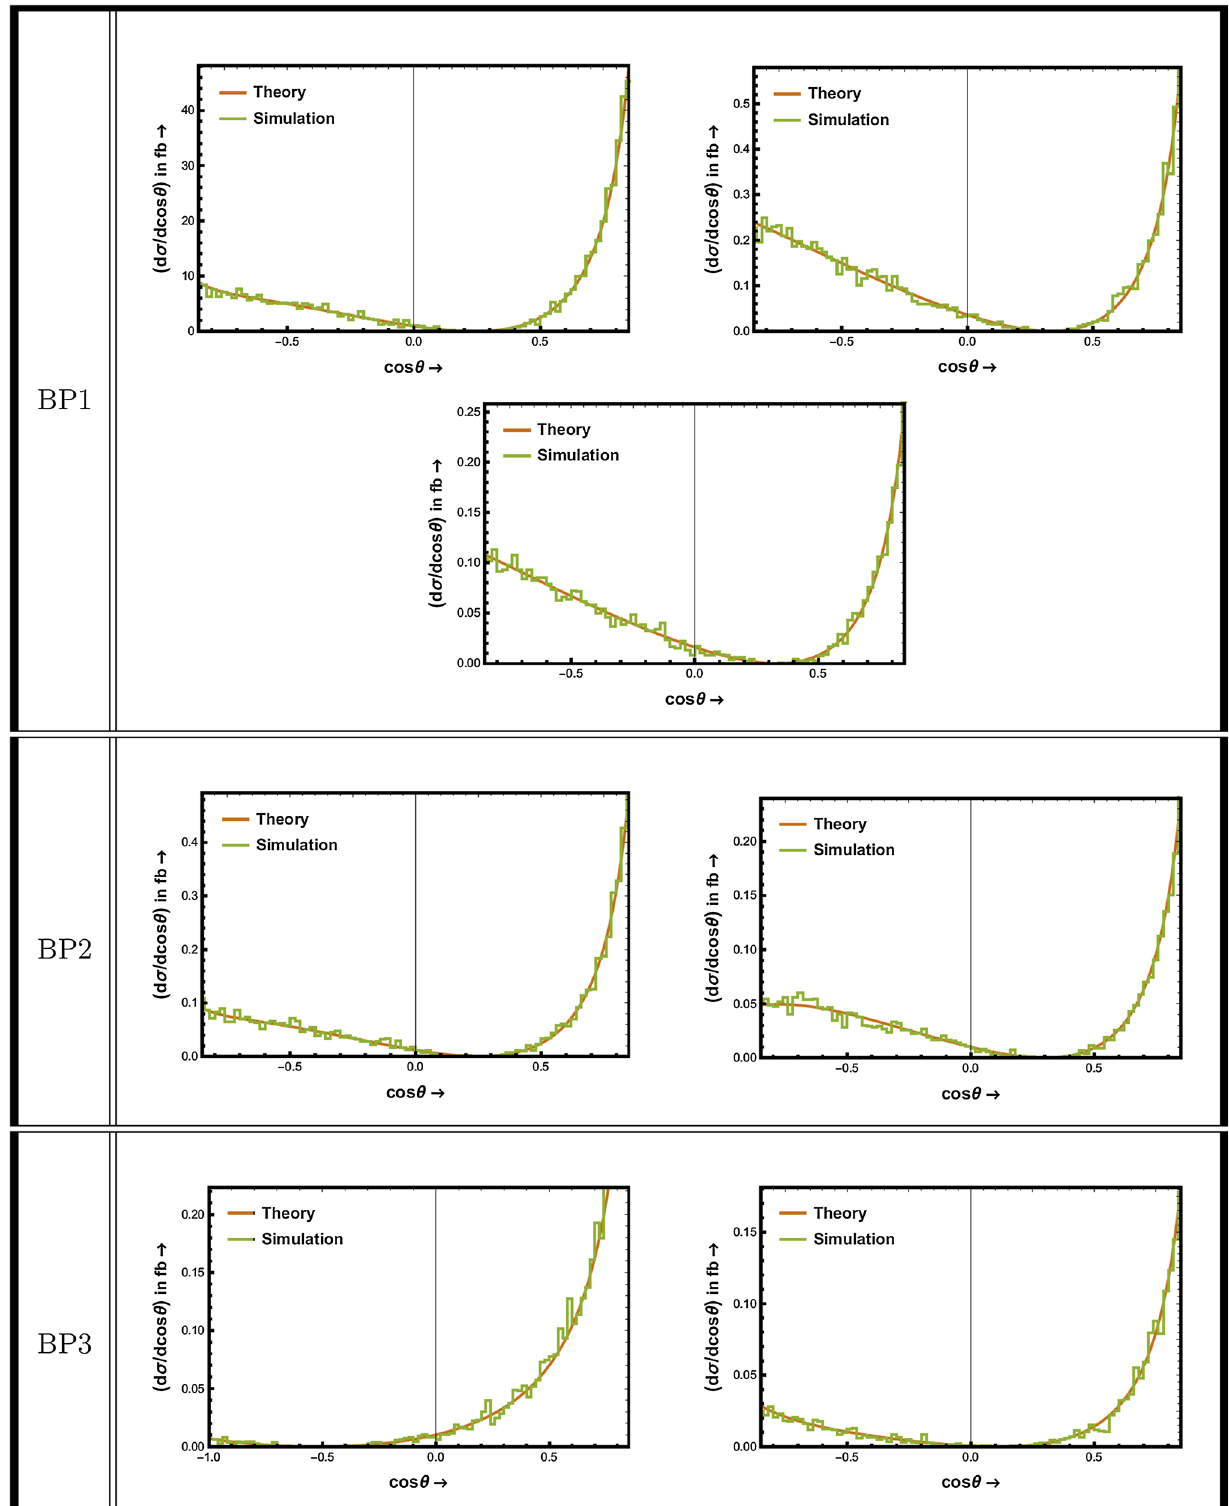
/ 3 ) c at various ical expectations, whereas the green (jagged) lines signify the PYTHIA 2 simulated